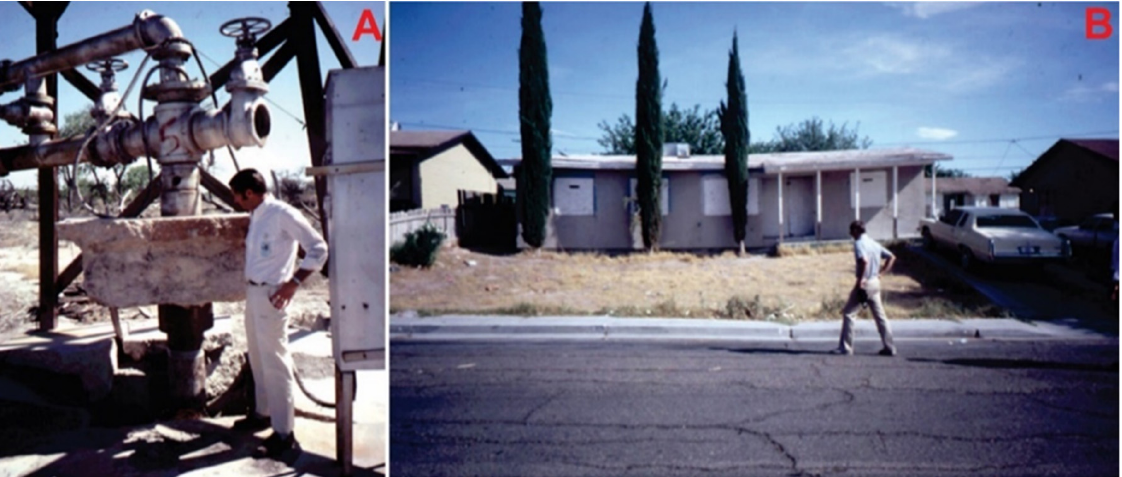
Figure 1. ( A ) drill pipes lifting, ( B ) Damaging house in the Windsor Park District due to land sub- sidence [48]